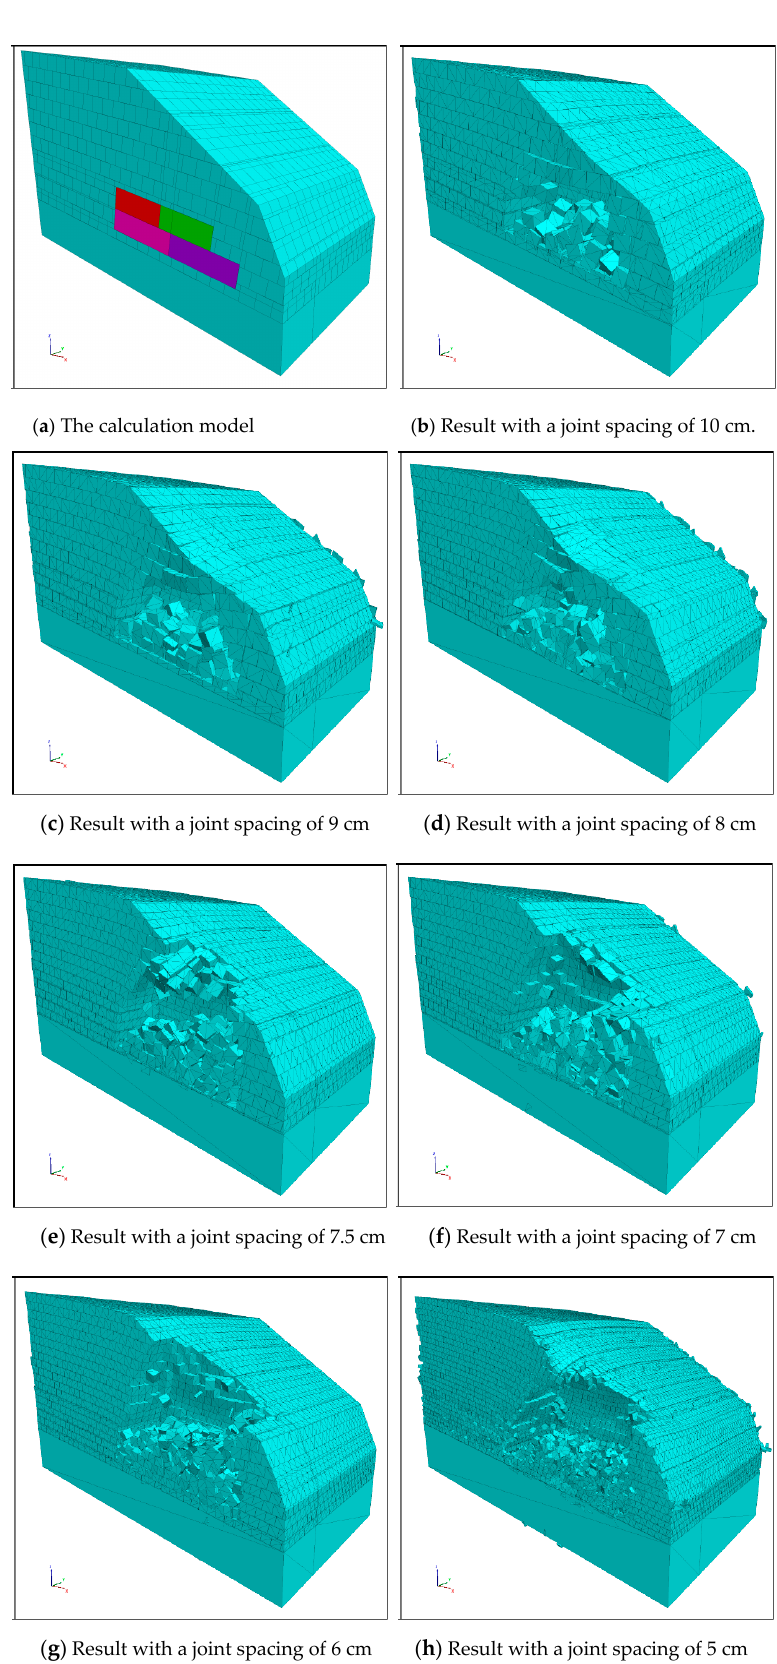
Figure 8. Results of numerical analysis at different joint spacing; ( a ) model setup; ( b ) 10 cm; ( c ) 9 cm; ( d ) 8 cm; ( e ) 7.5 cm; ( f ) 7 cm; ( g ) 6 cm; and ( h ) 5 cm.